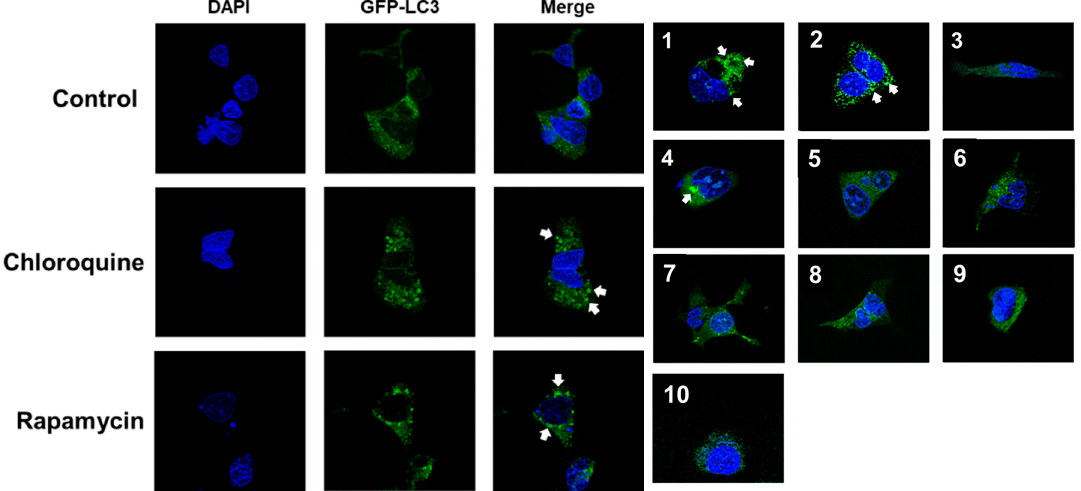
Figure 4. Screening of isolated alkaloids from L. scandens for regulation of autophagy. Compound treatment induced autophagosome formation in HEK293 cells. HEK293 cells stably expressing GFP- LC3 were incubated with 20 μ M compounds for 24 h, and the formation of LC3-GFP puncta was analyzed with confocal microscopy.